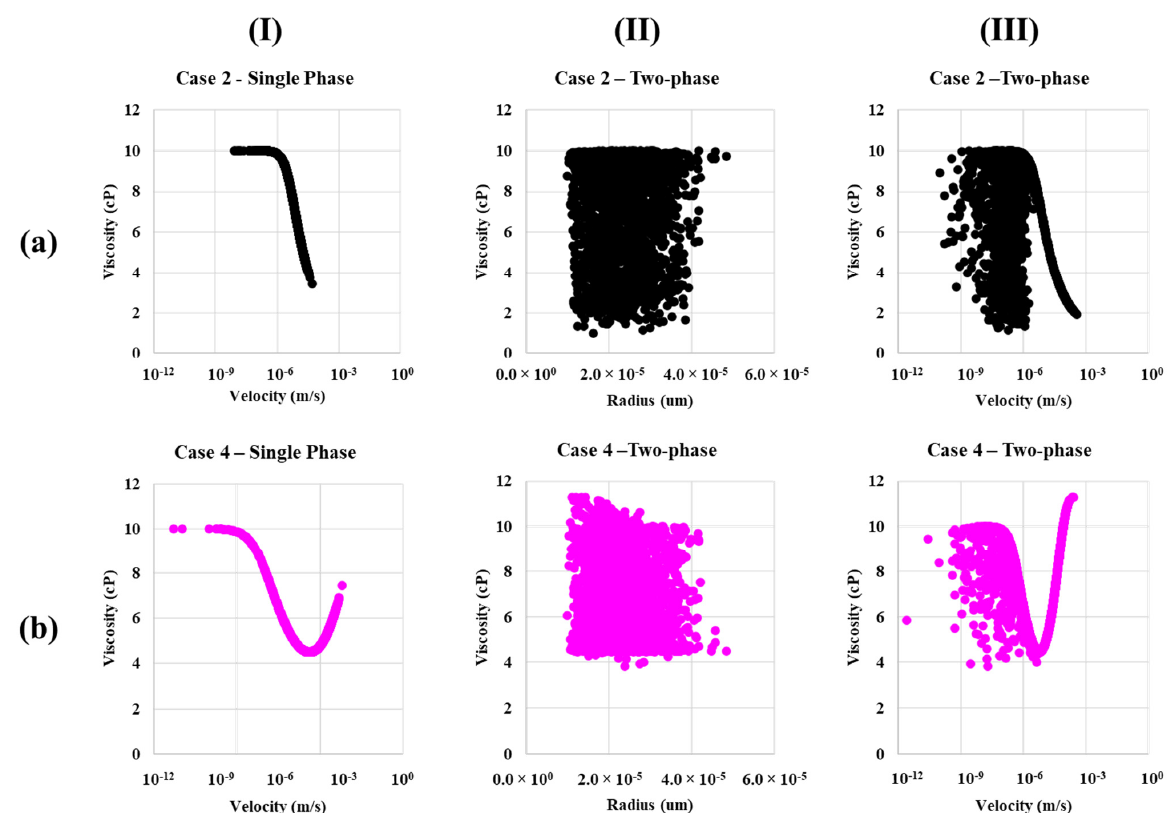
Figure 11. Single-phase viscosity versus velocity and multiphase viscosity versus radius and viscosity versus velocity for ( a ) case 2—Shear-thinning and ( b ) case 4—Shear-thinning and thickening.